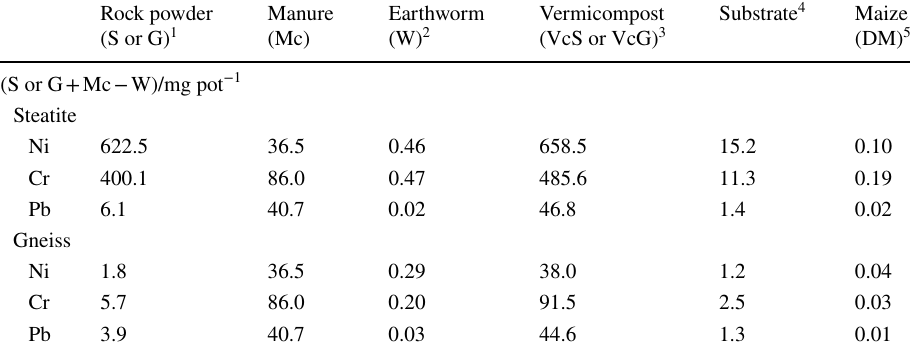
The maize was cultivated in pots, with soil fertilized with vermicompost enriched either with steatite (VcS) or gneiss (VcG) 1 Metal in 400 g of rock powder (steatite or gneiss); 2 Metal content of earthworms removed from the ver- micomposts (based on Table 3); ³the vermicompost was prepared with 3000 g cattle manure and either 400 g steatite powder (VcS, dry weight) or with gneiss powder (VcG, dry weight); 4 prepared with 3 kg of soil (no heavy metals detected), 7.5 g manure (Mc, dry weight), 3 g dolomitic lime and either 77 g of VcS or 79 g of VcG; 5 Dry matter of the plant (root